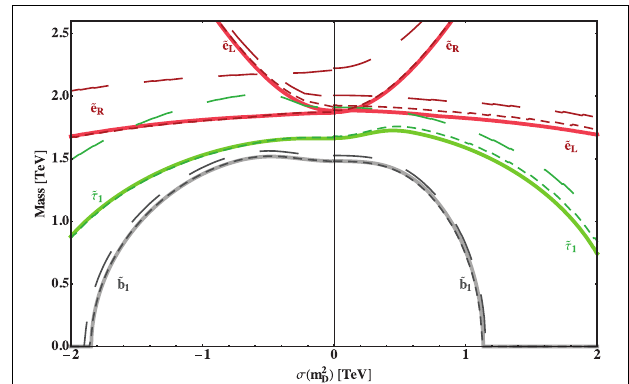
(cid:4) | m 2 | . ) = sign ( m 2 ) D D D